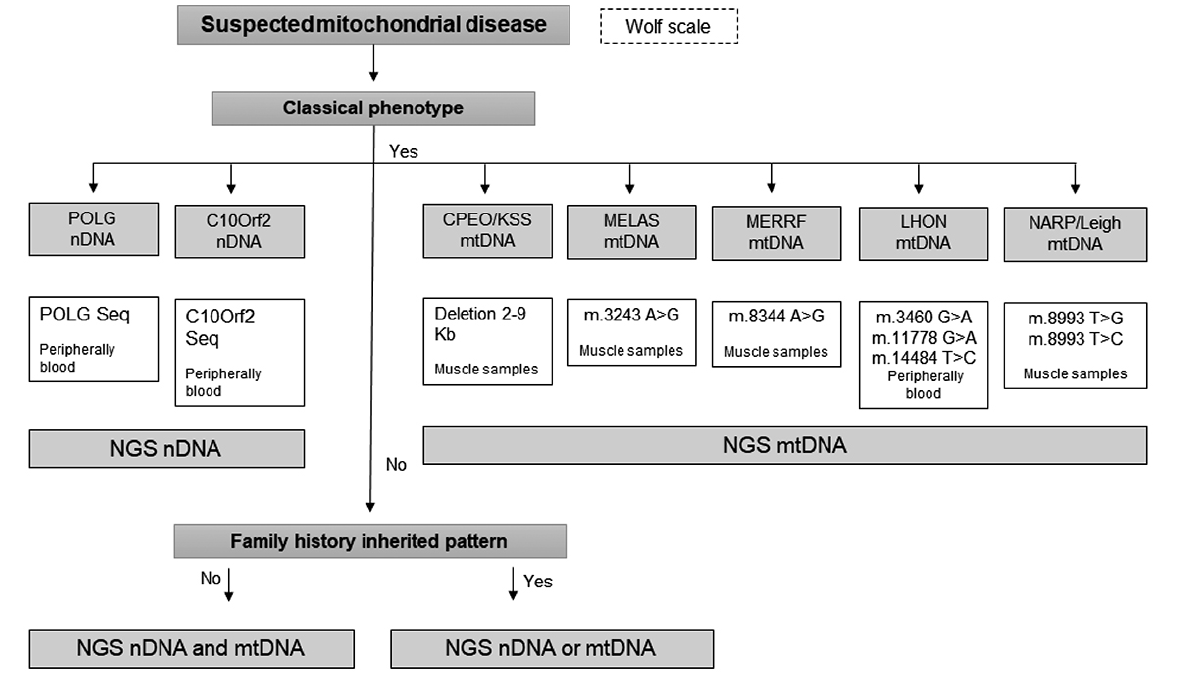
Figure 1. Clinical-molecular proposed algorithm: The first step is to determine what is the probability that the patient has a mitochondrial disease. In the second step, it is determined if it has a phenotypic presentation corresponding to a classic syndrome or not. If the patient presents a classic phenotype, the search for point mutations and / or structural alterations in the mtDNA or the sequencing of candidate nuclear genes such as C10Orf2 or POLG, as appropriate, is performed. In the event that these studies are negative, sequencing of the complete exome and / or the mitochondrial genome is continued, as indicated by the pattern of inheritance observed in the family